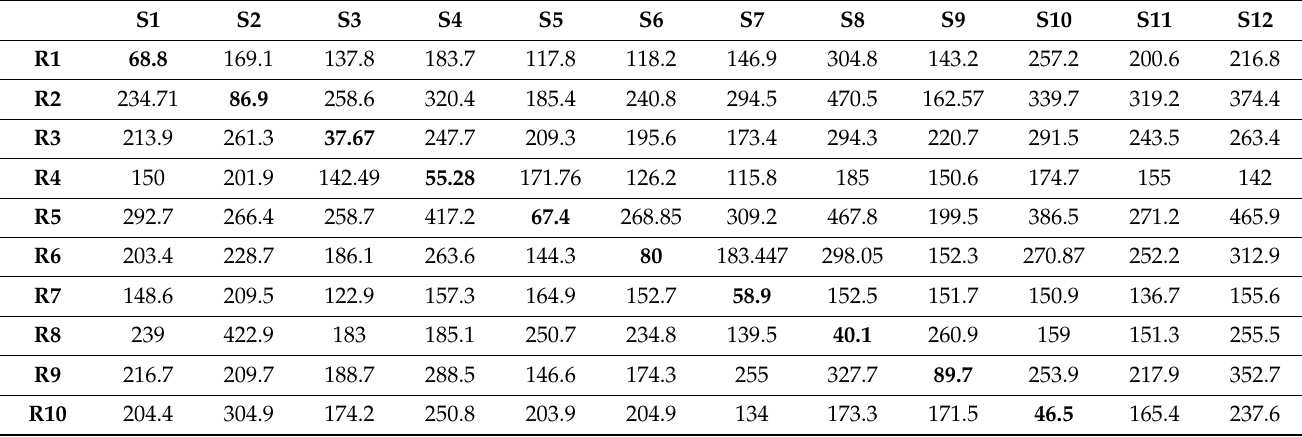
Table 1. Inter-subject authentication